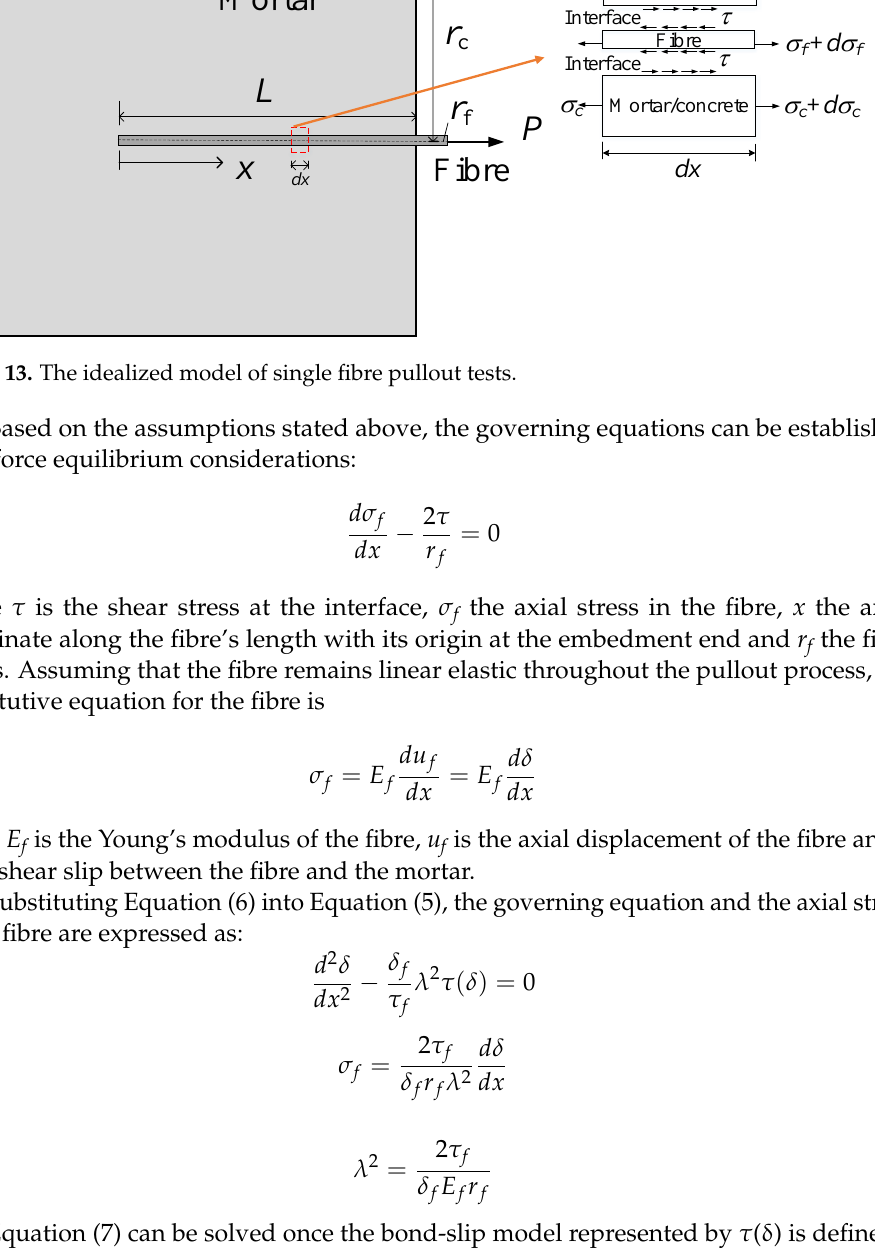
and parameter calibrations against the experimental pullout curves. Closed-form analytical solutions have been derived in our previous study [43] for the whole pullout process of rockbolts. Although mechanically very similar, the solutions in [43]